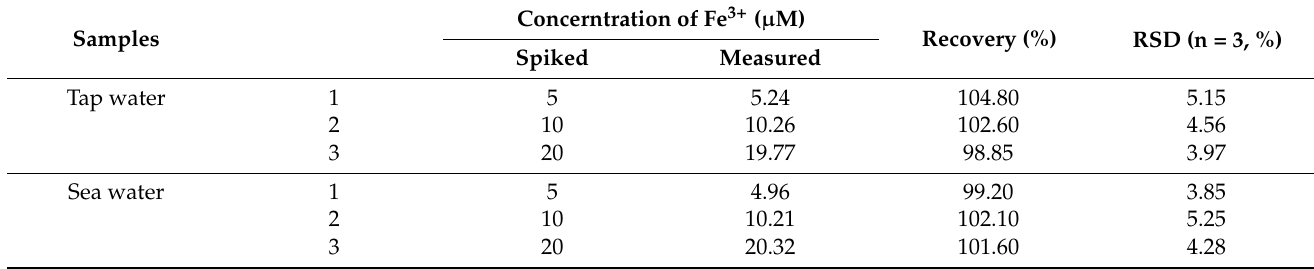
Table 2. Determination of Fe 3+ in tap water and sea water